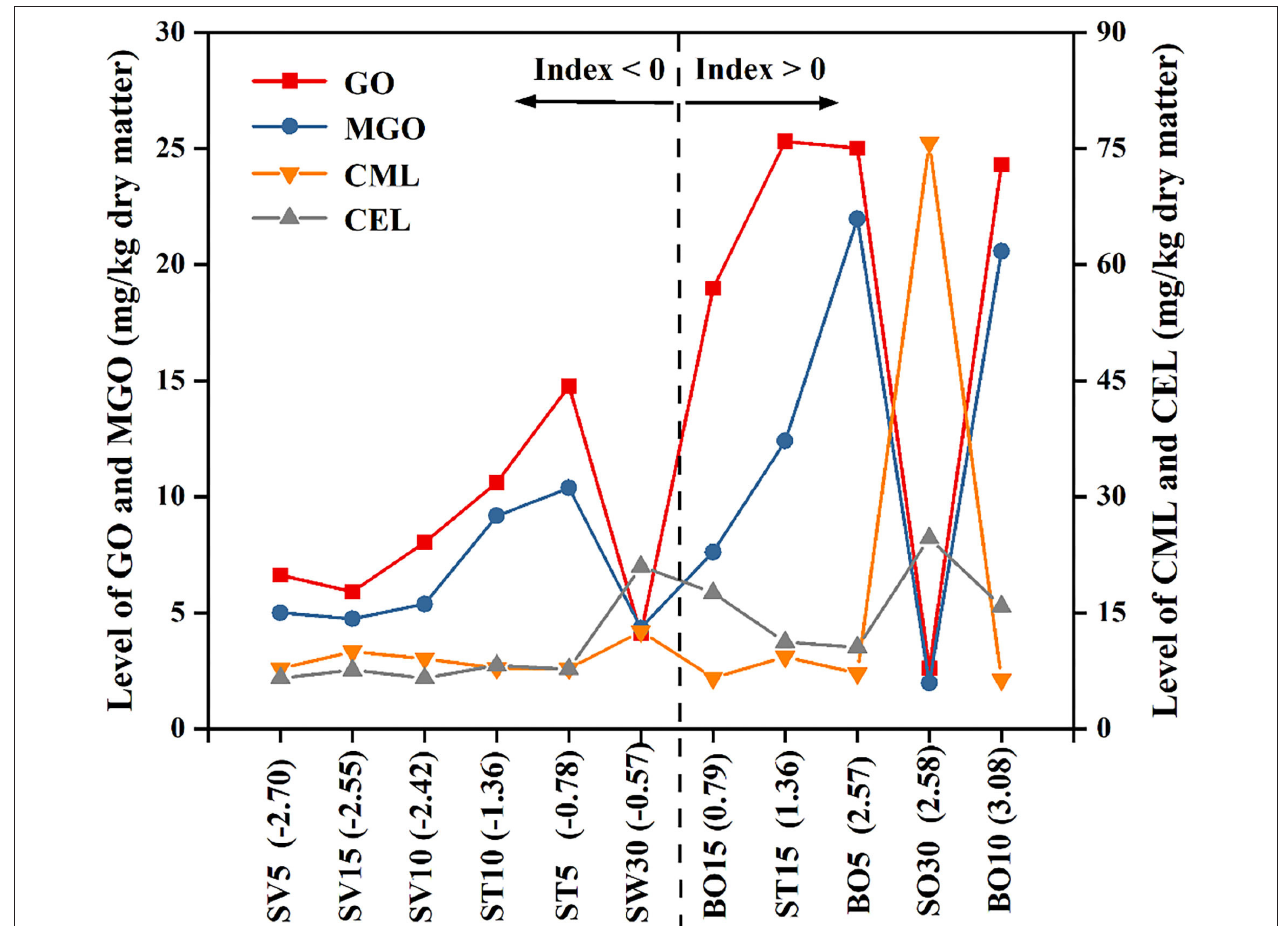
FIGURE 6 | The distribution of various processed oysters based on Z -score